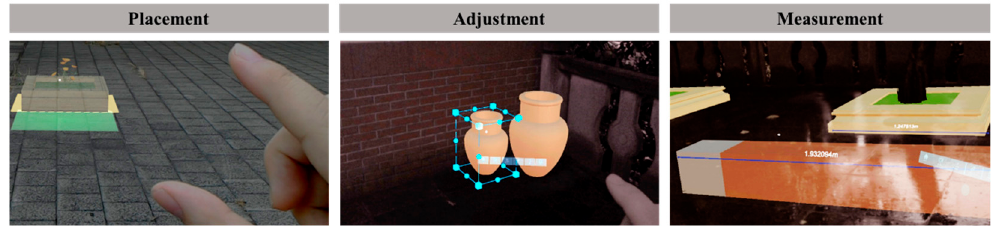
Figure 8. The real-time control for the virtual design objects using MR.